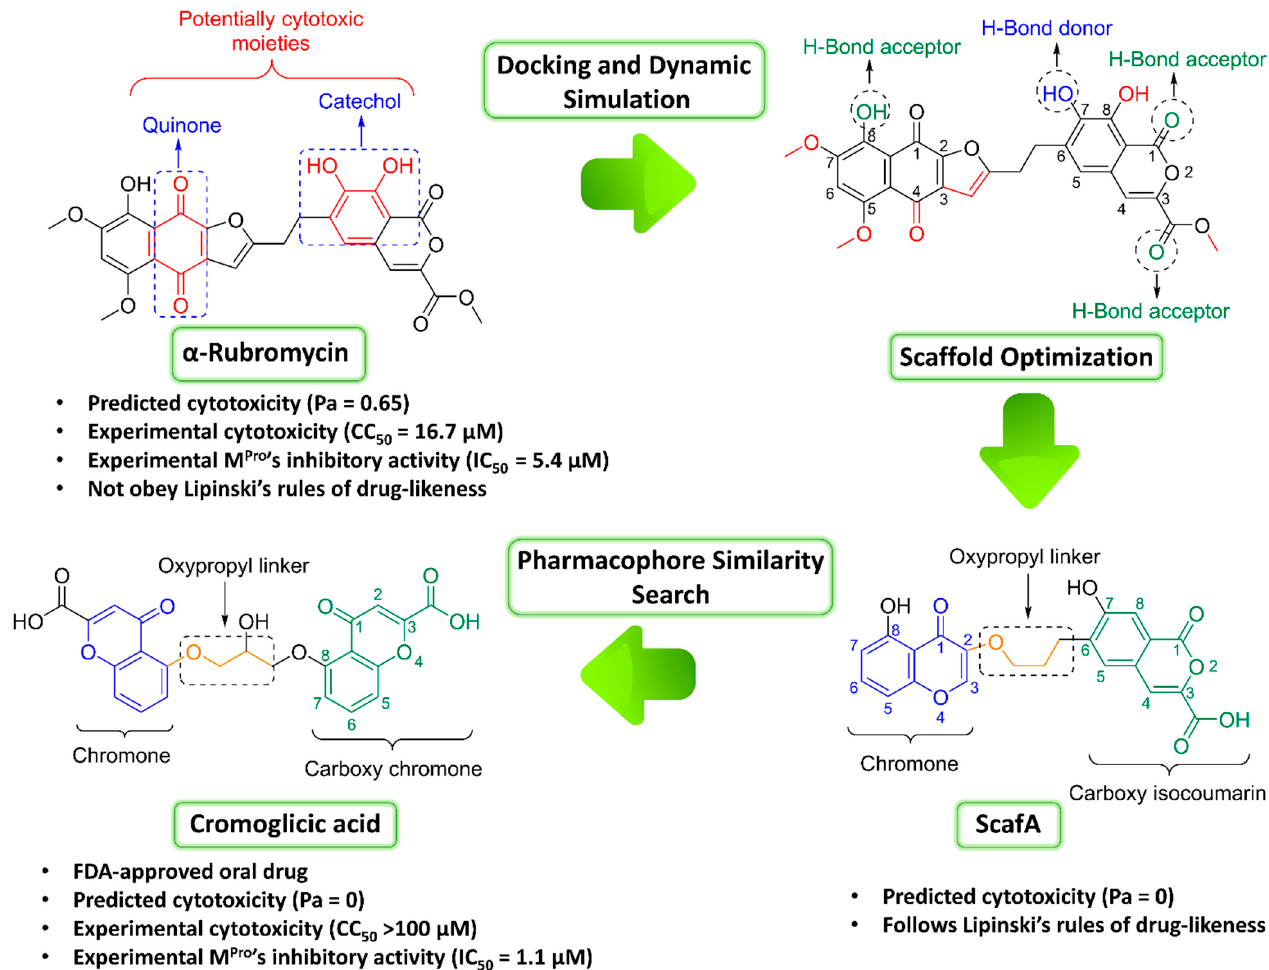
Figure 2. The general outline of the present investigation illustrating the main steps starting from α -rubromycin and eventually reaching cromoglicic acid.